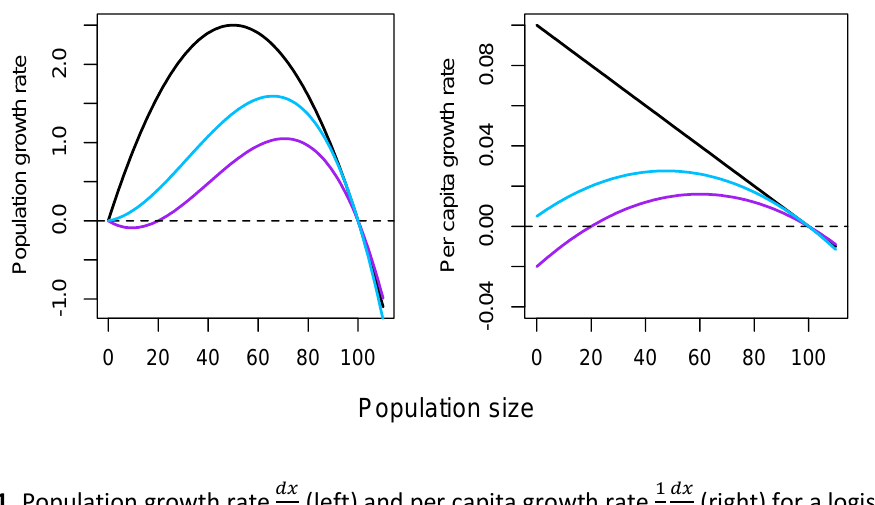
𝑑𝑥 Figure 1. Population growth rate (left) and per capita growth rate 𝑑𝑡 black), a model with a weak Allee effect (A=-5, in blue) or a model with a strong Allee effect (A=20, in purple) when r=0.1 and K=100. After Drake and Kramer